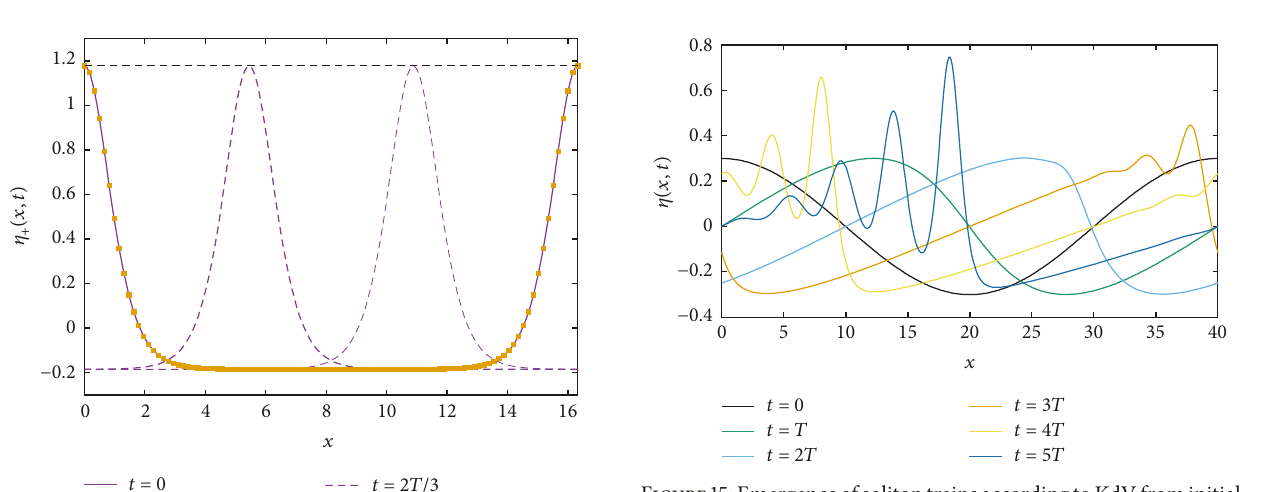
Figure15:EmergenceofsolitontrainsaccordingtoKdVfrominitial cosine wave. 𝐴 = 0.3, 𝑇 = 50